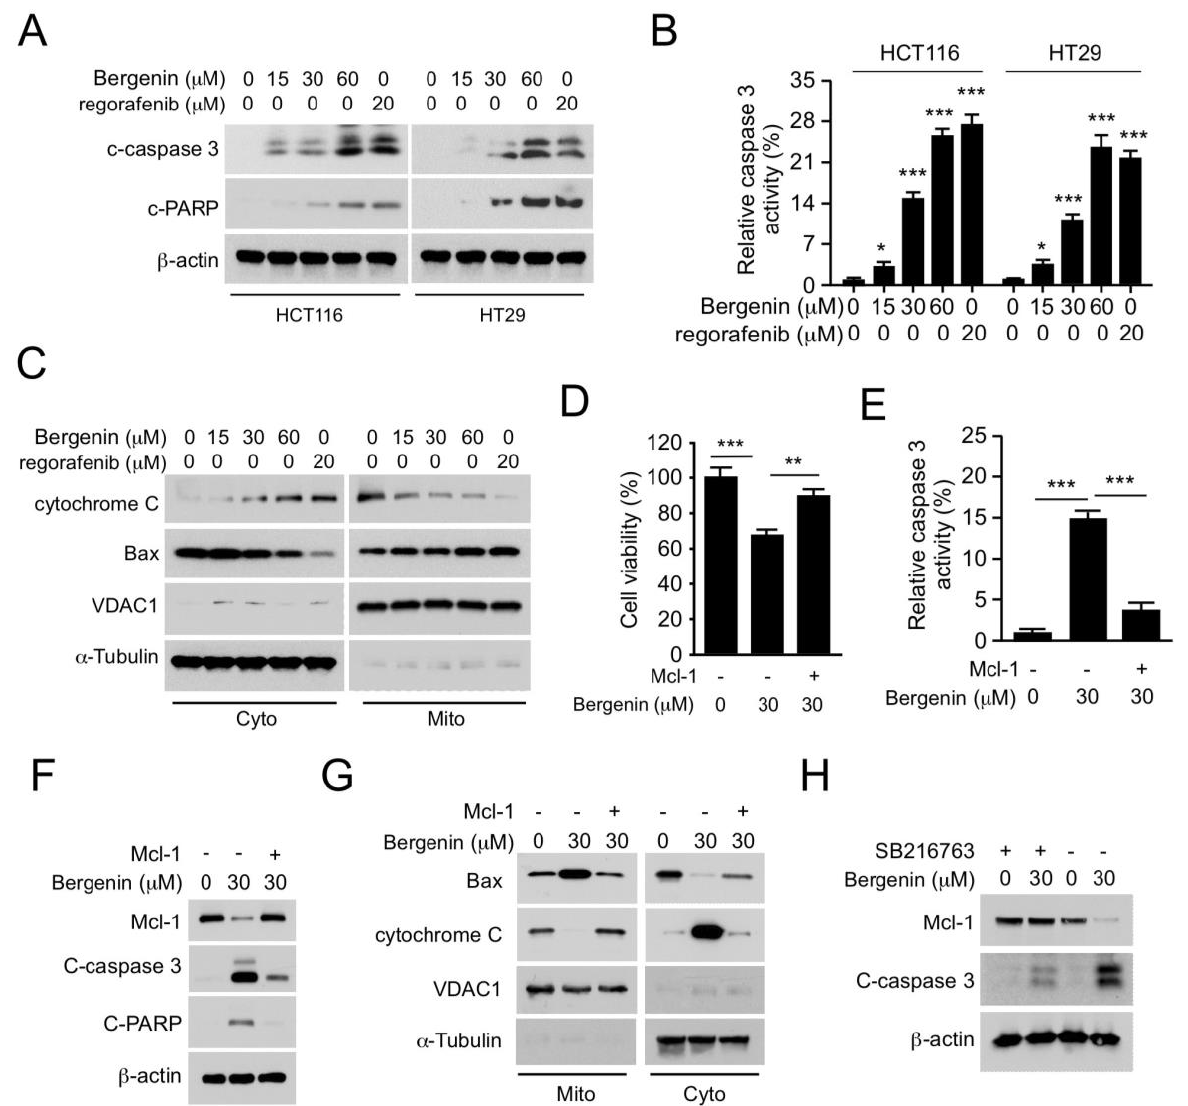
Figure 4. Bergenin induces apoptosis of CRC cells. ( A , B ) Bergenin − treated or regorafenib − treated HCT116 and HT29 cells were cultured for 48 h. WCE were collected for IB analysis ( A ), and